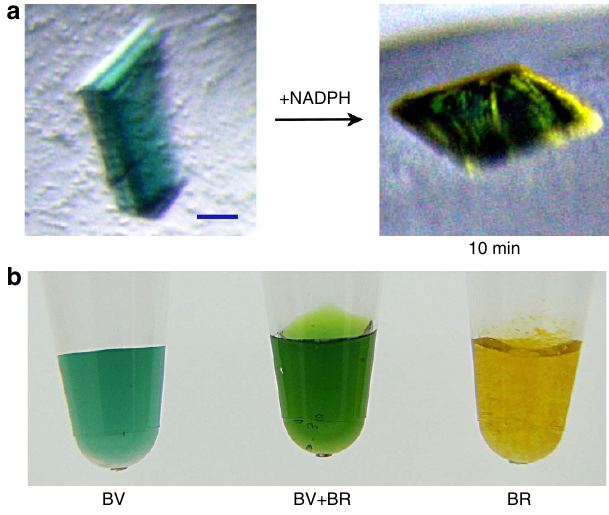
Figure 4 | The enzymatic reaction in the crystalline state. ( a ) The BV reduction could proceed in the crystal by adding NADPH. Right, 10min after the reaction. The bluish-green colour in the crystal (left) is derived from the bound BV. The yellow–green colour in the crystal (right) is probably derived from the mixture of BV and BR. Scale bar, 20 m m ( b ) The colours of the pigments in solution, provided as a reference: BV (left); mixture of BV and BR (middle) and BR (right). Final concentrations of all pigments were adjusted to